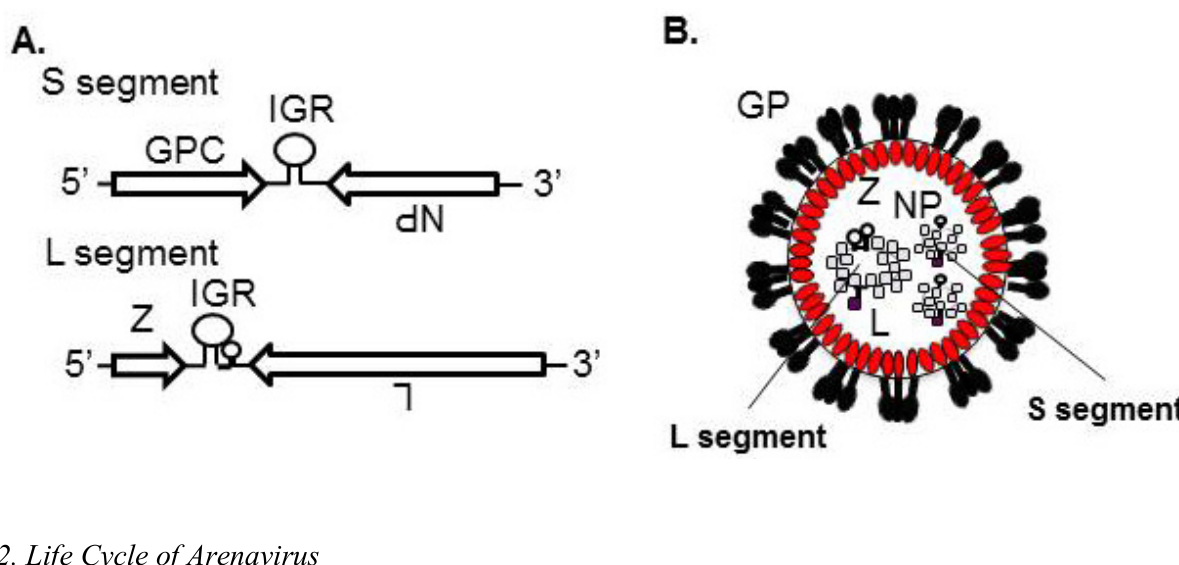
Figure 2. Genomic organization and virion structure of arenavirus. ( A ) Arenaviruses are enveloped viruses with a bisegmented NS RNA genome. Each genome segment uses an ambisense coding strategy to direct the synthesis of two viral polypeptides. The S segment encodes the NP and GPC. The L segment encodes the L and Z. ( B ) GP, which is posttranslationally processed by the cellular protease S1P/SKI-1, decorates the virion surface. Z lines the inside of the virion membrane. The viral genome encapsidated by NP and L is incorporated inside the virion. IGR: Intergenic